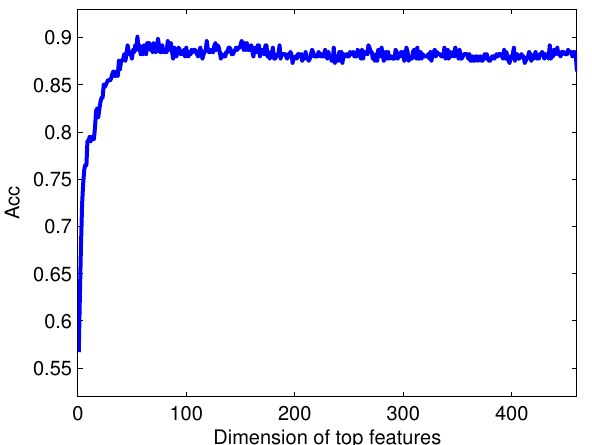
Figure 5. The Acc value against the dimension of top features. The maximum Acc value is 0.901 when the first 55 features in the ranked feature list are selected. Table 5 shows the 10 fold cross-validation prediction results using 3-gap DC+CSP-PSSM-DC+CSP-Bi-gram PSSM+CSP-ED-PSSM with feature selection (RF-RFE) and